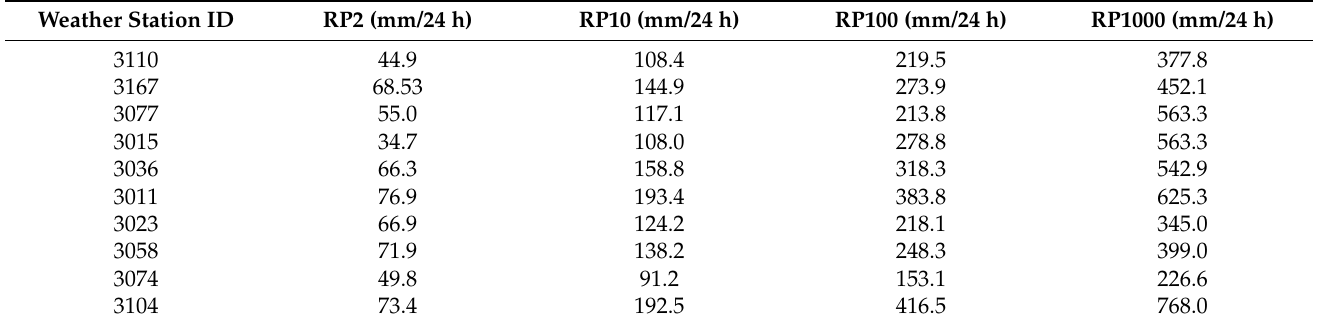
Table 2. Return periods calculated for each weather station considering the maximum rainfall in 24 h